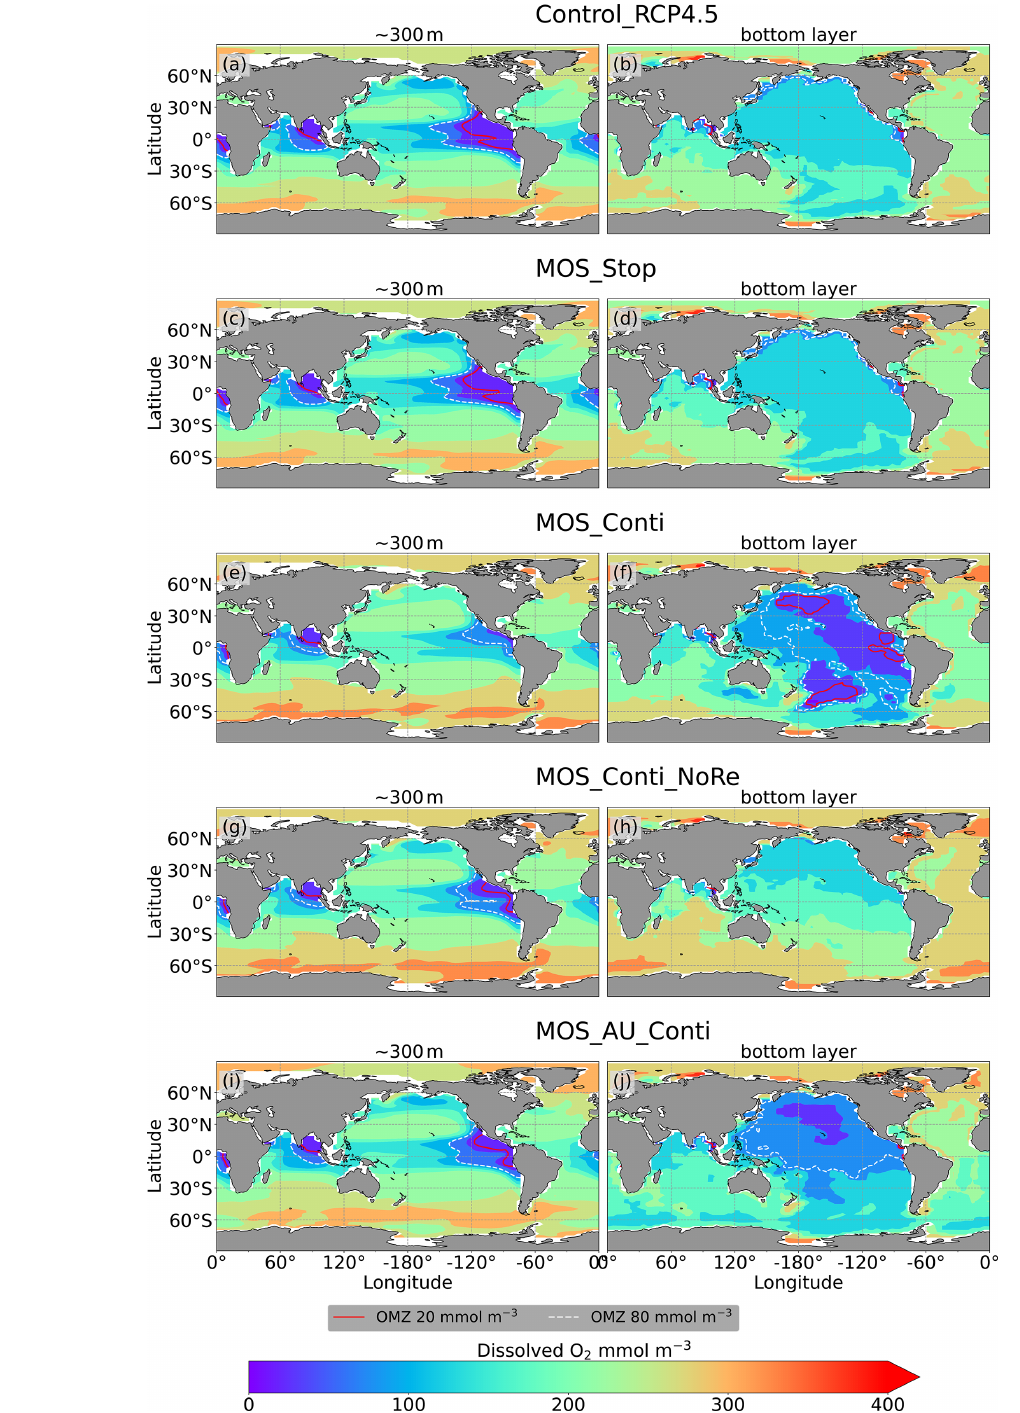
Figure 11. Dissolved O 2 concentrations at depth ∼ 300m (left panel) and the ocean bottom (right panel) in year 3000: contour lines indicate boundaries of OMZs with less than 80mmolm − 3 oxygen (dashed white) and less than 20mmolm − 3 oxygen (solid red). Continuous MOS deployment further shrinks the OMZ at 300m depth (e, g, i) but expands them at the bottom (f, j) , except for the zero-remineralization one in (h)